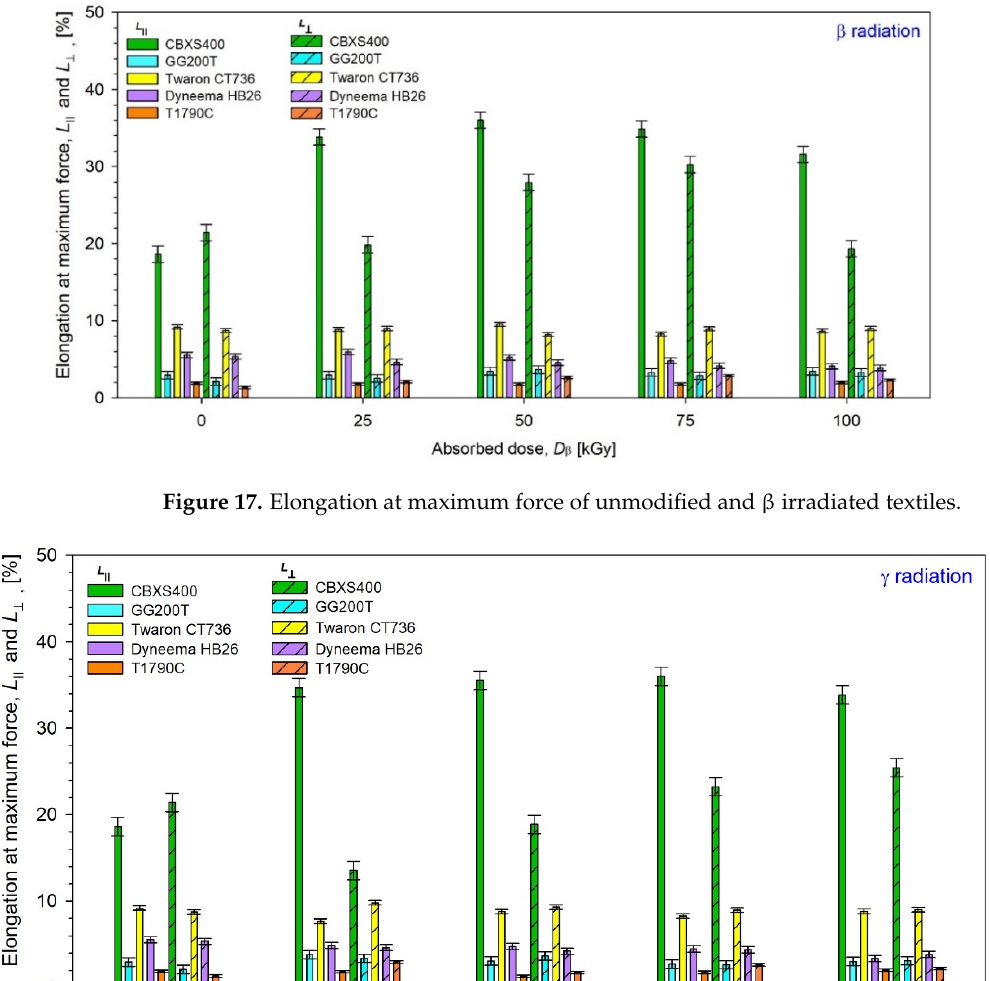
Figure 16. Maximum force of unmodified and γ-irradiated textiles.